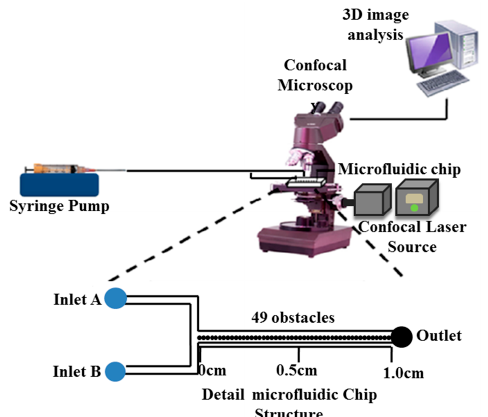
Figure 5. Experimental setup for bacterial activity, biofilm growth and eradication with a microfluidic sensor with microstructures.